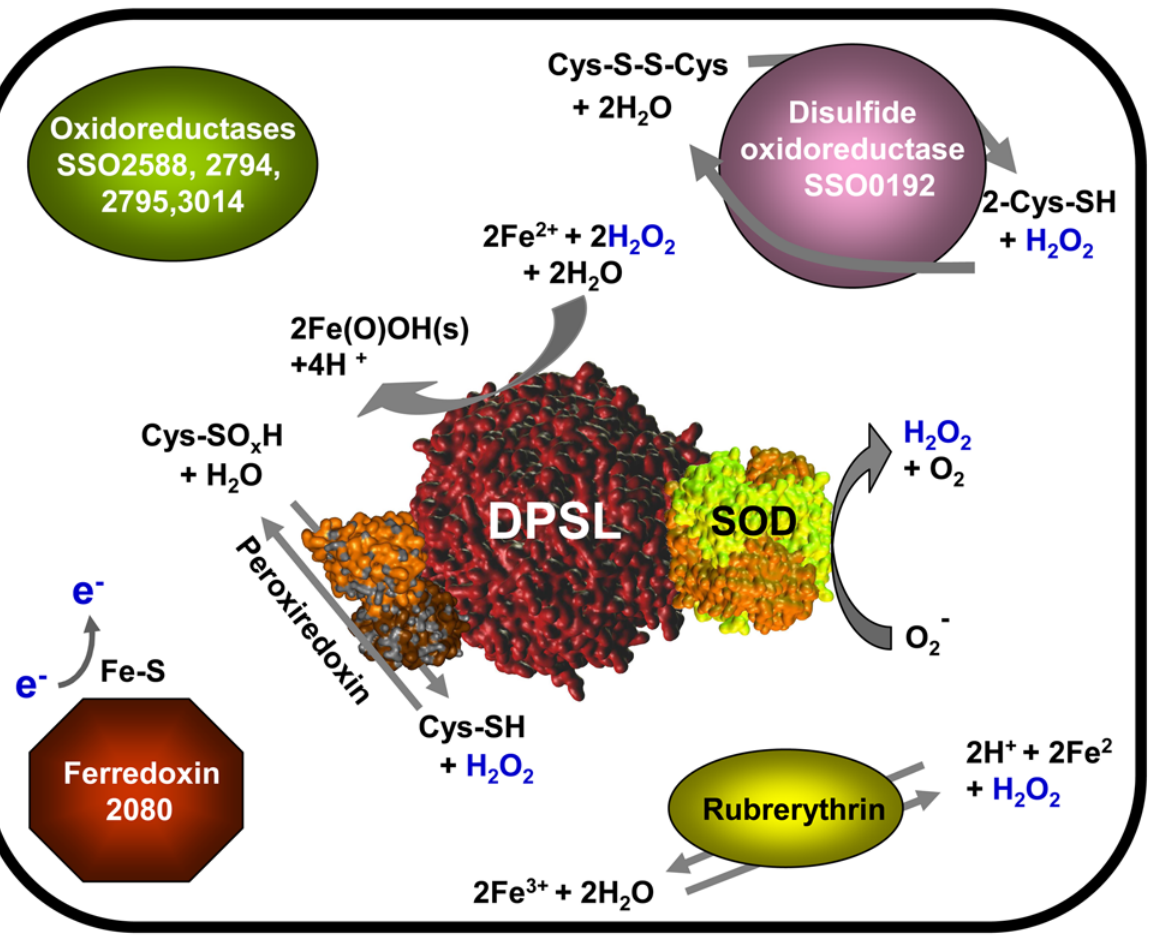
Figure 9. Schematic of the oxidative stress response in S.solfataricus based on mRNA and protein regulation after hydrogen peroxide exposure. Numbers indicate gene number (SSO). DPSL, SOD, and Peroxiredoxin are part of a molecular complex that can coordinate removal of ROS by converting highly reactive superoxide into H 2 O 2 and then using this as substrate in subsequent reactions.